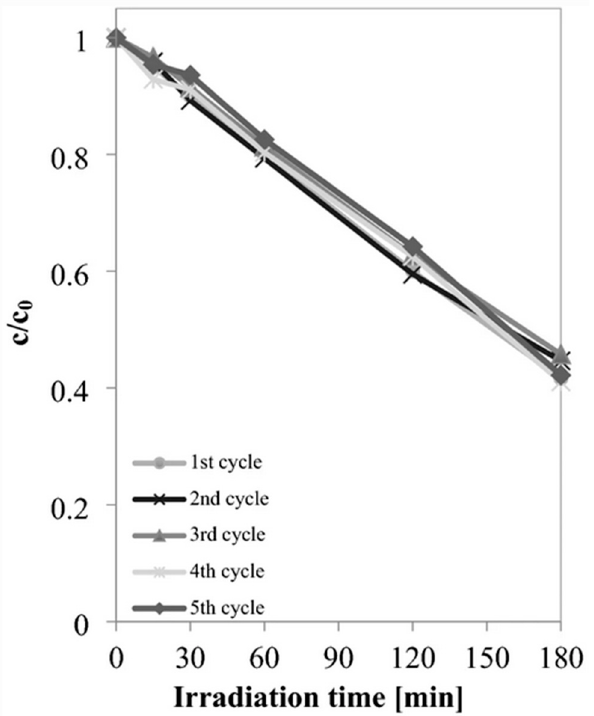
Figure 9. Stability of N-TiO 2 /PS structured photocatalyst in AO7 discoloration. Adapted from [105]. Moreover, the final values of TOC removal efficiency (about 54%) were very close to the AO7 discoloration efficiency; thus, it could be argued that total conversion to CO 2 and water occurred thanks to a developed photocatalytic system (photoreactor with flat-plate geometry + N-TiO 2 /PS structured photocatalyst).